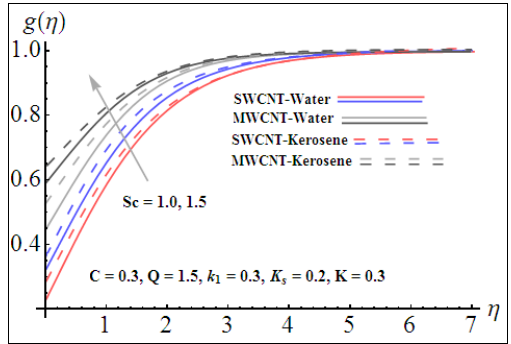
Figure 11. Behavior of g ( η ) for increased values of K s .